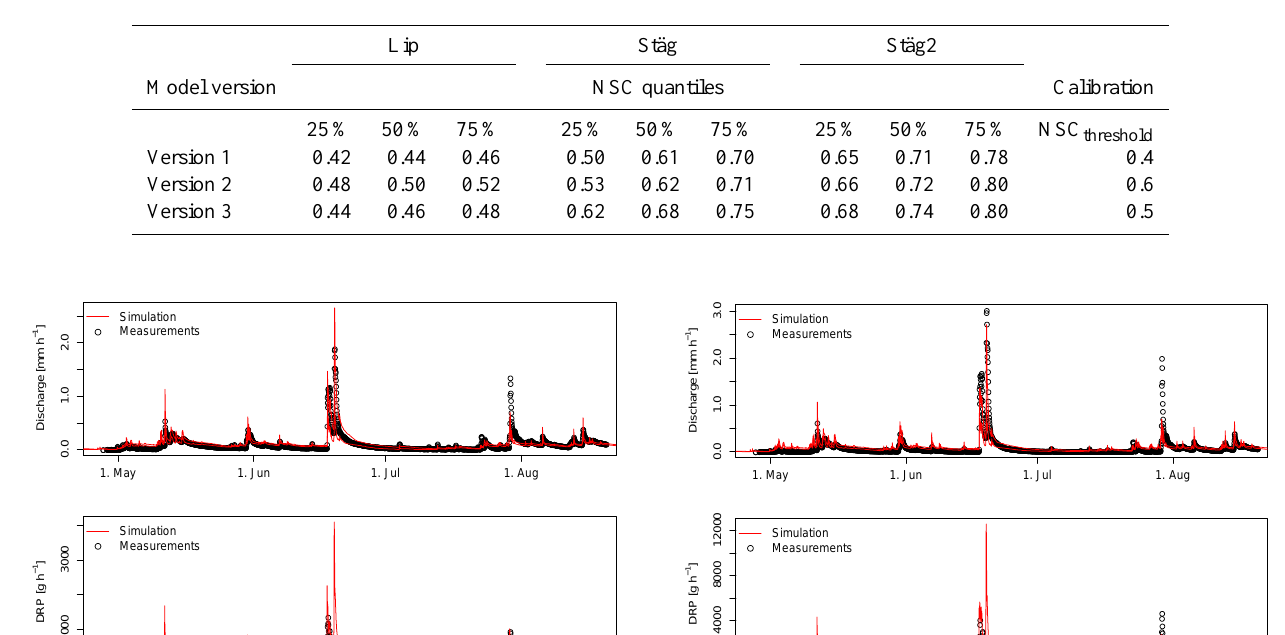
Table 4. Performance of different model versions in three catchments (Lippenrütibach catchment (LIP), Stägbach catchment (Stäg), Stägbach sub-catchment (Stäg2)), measured with the Nash–Sutcliffe criterion (NSC) (Nash and Sutcliffe, 1970). Version 1 – corrected original model, Version 2 – separate urban parameter calibration, Version 3 – separate urban parameter calibration + different soil classification.